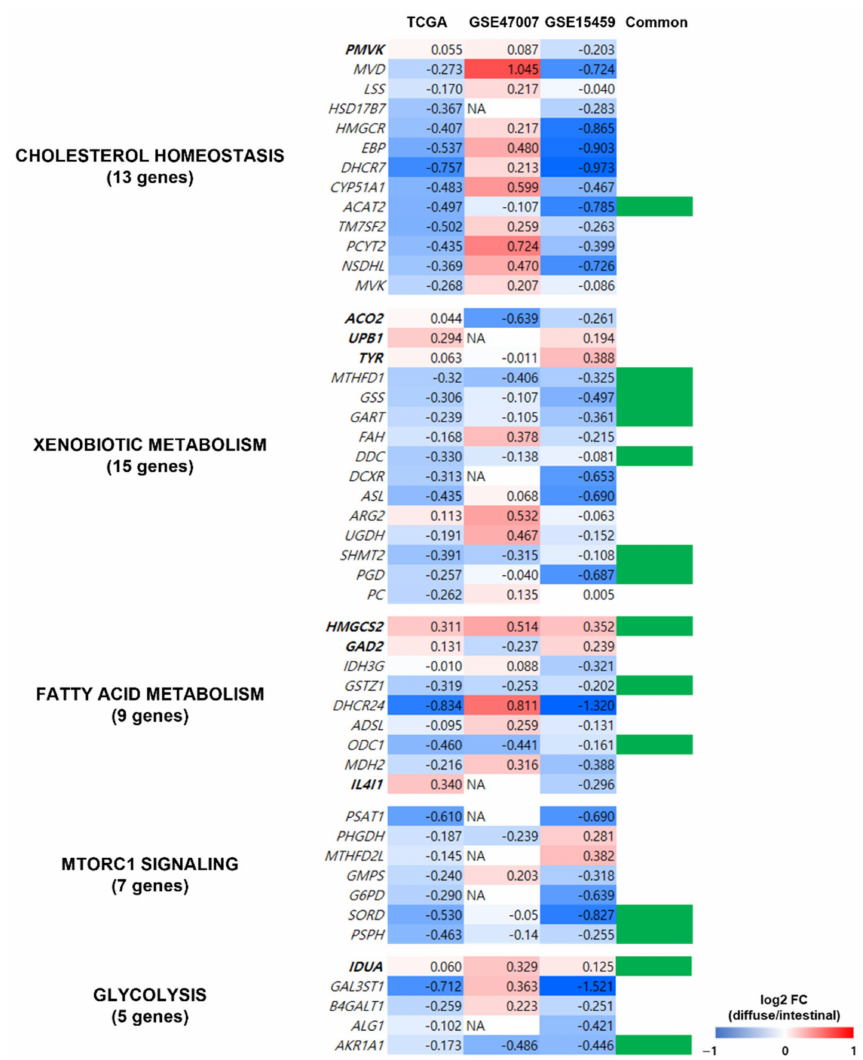
Figure 6. Validation of metabolism-related genes in the independent datasets of patients with GC. The expression profiles of the 49 genes of the five metabolic pathways (indicated in Figure 5B) were validated using gene expression profiles from two independent datasets of patients with GC (GSE15459 and GSE47007). Genes in bold were upregulated in diffuse compared to intestinal types in the TCGA GC dataset, and the genes in regular font were downregulated. Column “Common” indicates whether the gene showed similar gene expression profiles in all three datasets, and 14 genes (indicated in green in column Common) had similar expression profiles (diffuse versus intestinal subtypes) in TCGA and the other independent